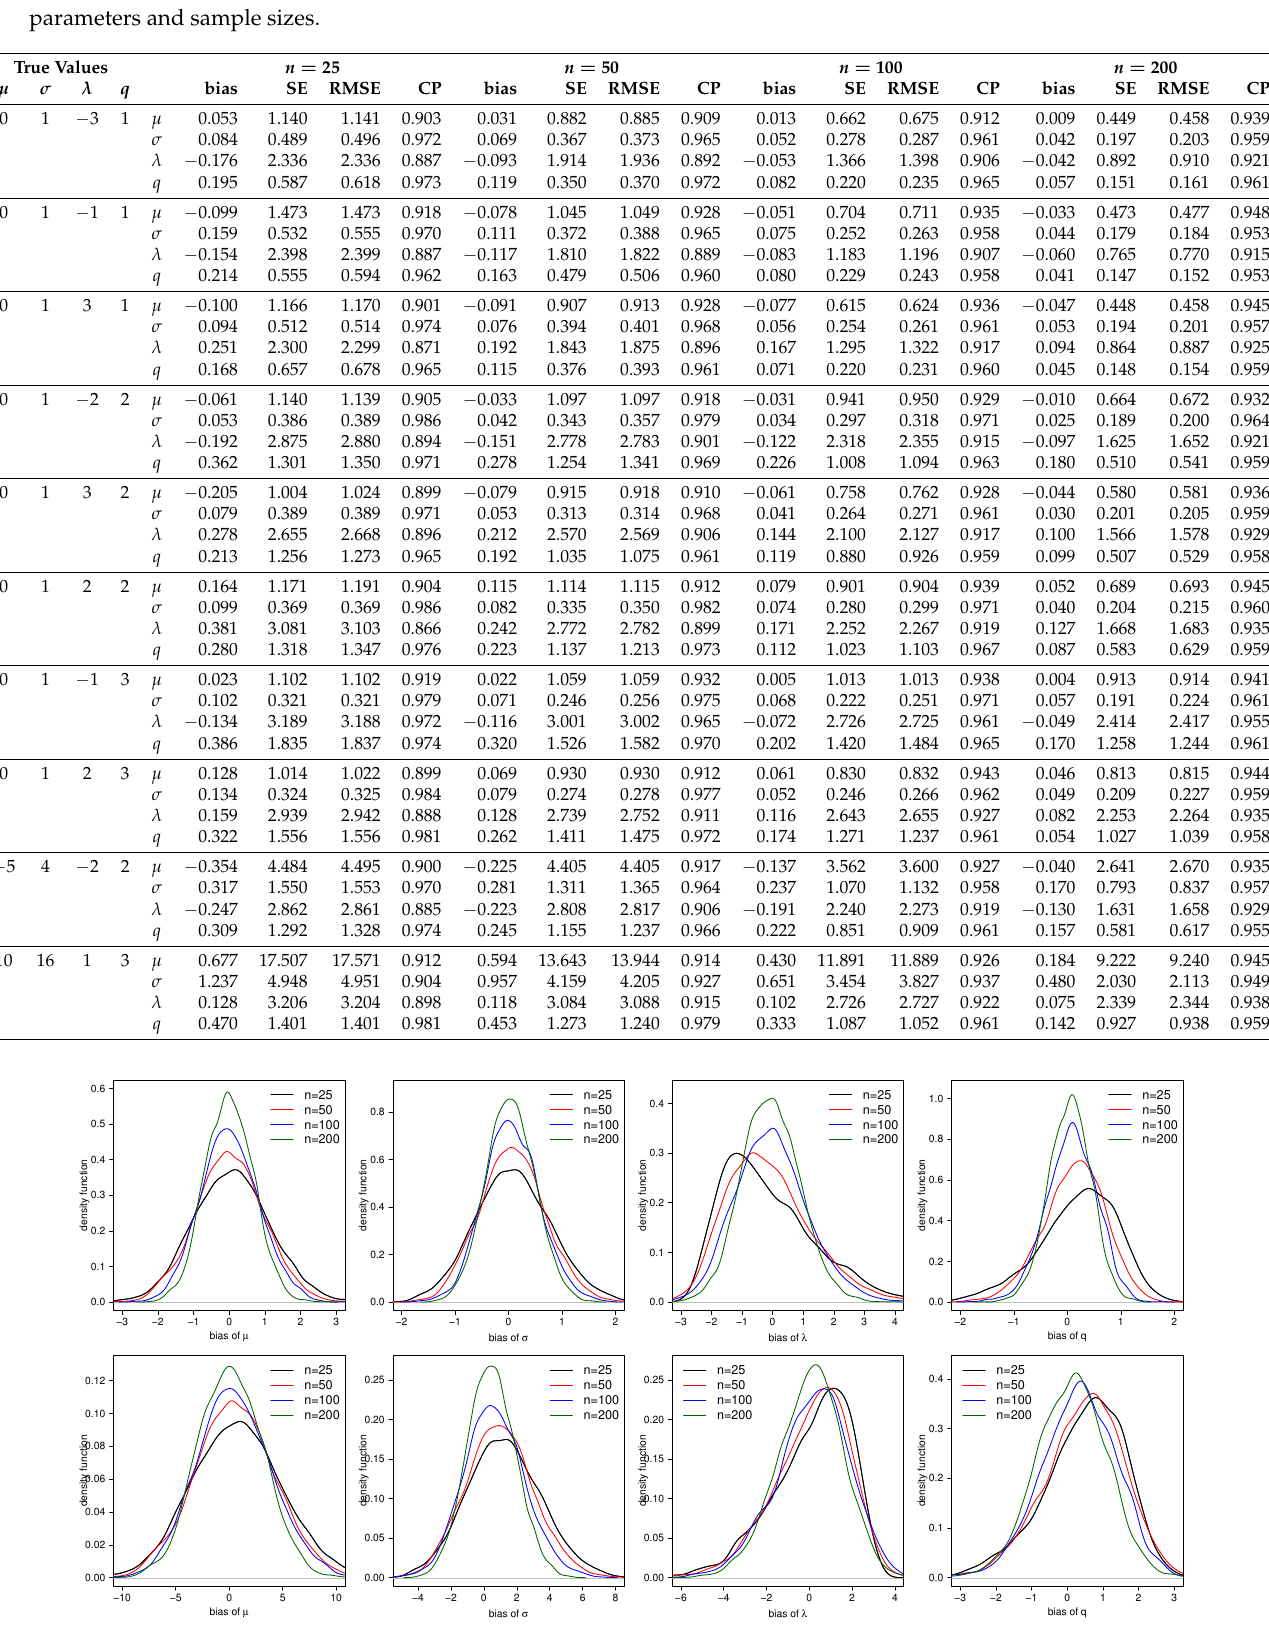
Figure 4. Estimated pdf for the ML estimators of µ , σ , λ , and q in the TESN distribution for: µ = 0, σ = 1, λ = − 3, q = 1 (upper panels), and µ = 10, σ = 16, λ = 1, q = 3 (lower